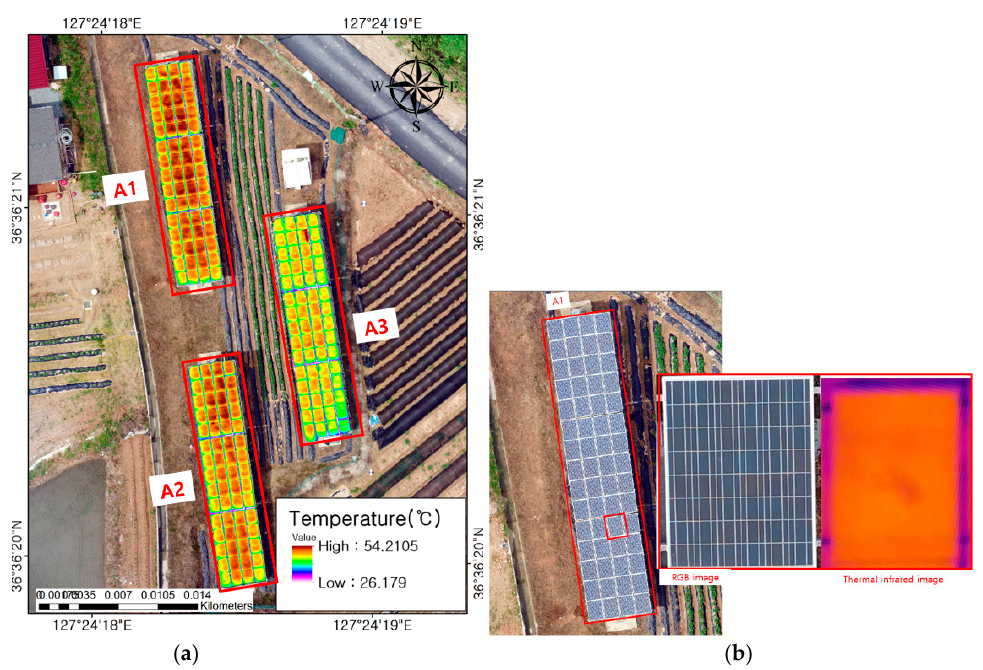
Figure 6. Optical image and thermal infrared photographing temperature distribution by module and array of solar panel. ( a ) Temperature distribution for each array module; ( b ) RGB image and temperature distribution of module.